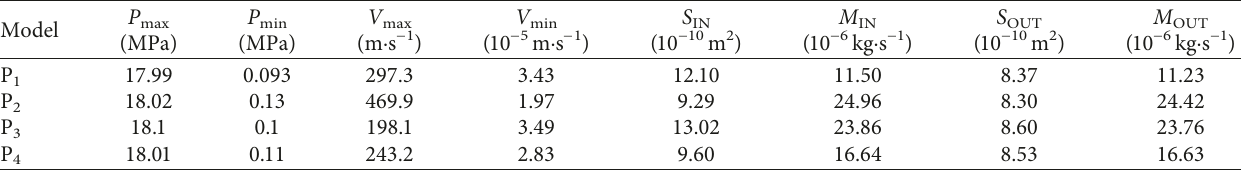
Table 9: Simulated results of seepage parameters in four models under an ultrahigh inlet pressure of 18.1 MPa.